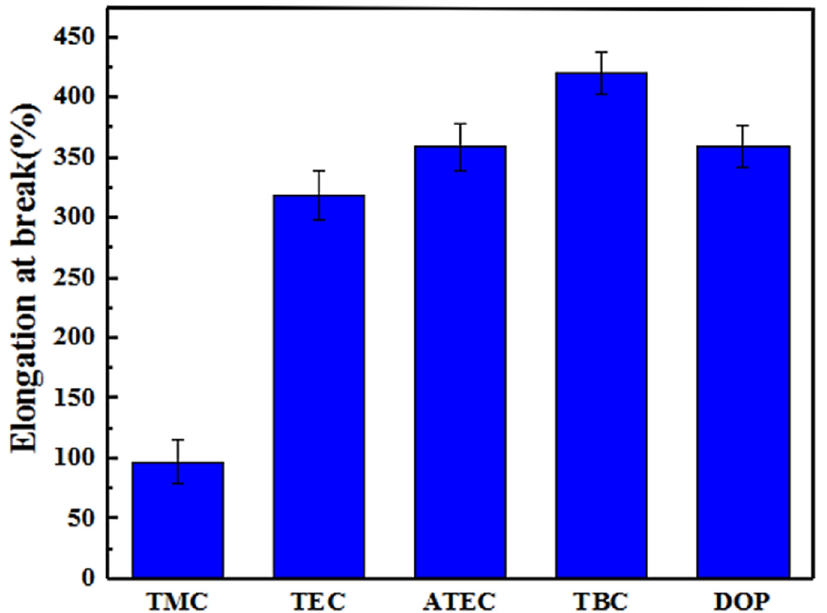
Figure 5. The elongation at break of PVC with Zn(Arg) 2 plasticized by citric acid esters or DOP. In order to further confirming the flexibility of the PVC chains in different samples, the glass transition temperatures (T g ) of the PVC samples were tested and shown in Figure 6. Figure 6 shows that T g of PVC with TBC is the lowest (41.91 °C), close to the T g of DOP plasticized PVC sample (43.44 °C), which indicates that chains in the PVC sample with Zn(Arg) 2 and TBC has good mobility. It may be caused by the little conjugated double bonds in PVC chains, or the small intermolecular force between PVC chains. The T g of PVC with ATEC, TEC, and TMC groups were 51.80 °C, 54.81 °C, and 62.23 °C, respec- tively. The results also hint the longer the carbon chains in citric acid esters, the lower the T g of PVC samples, and the ester group is benefit to the low T g , as same as the transparency and the elongation at break of the PVC samples.